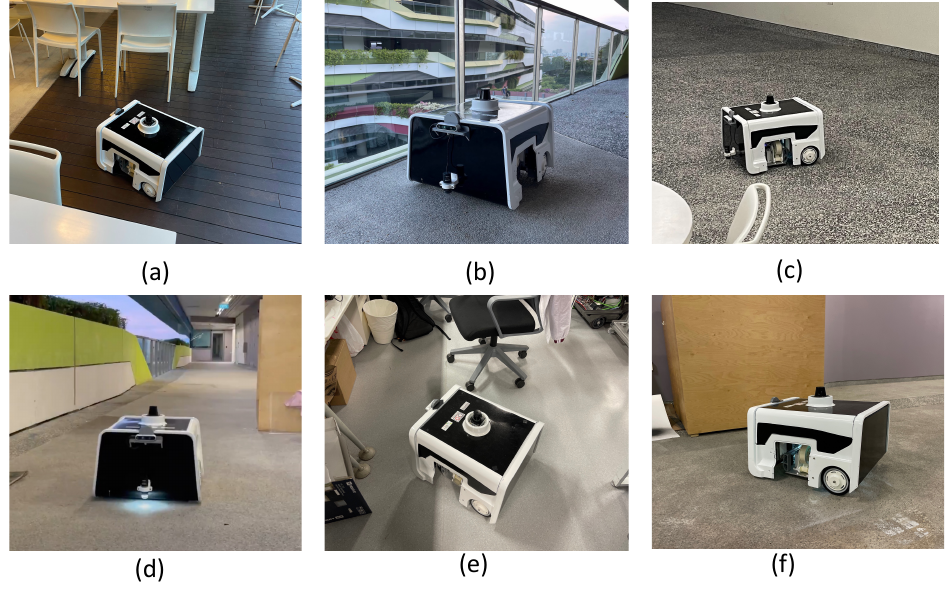
Figure 5. The dirt sample collection using the BELUGA robot in different locations such as a food court ( a ), semi-indoor walkway ( b ), office pantry ( c ), long corridor ( d ), office space ( e ), and warehouse ( f